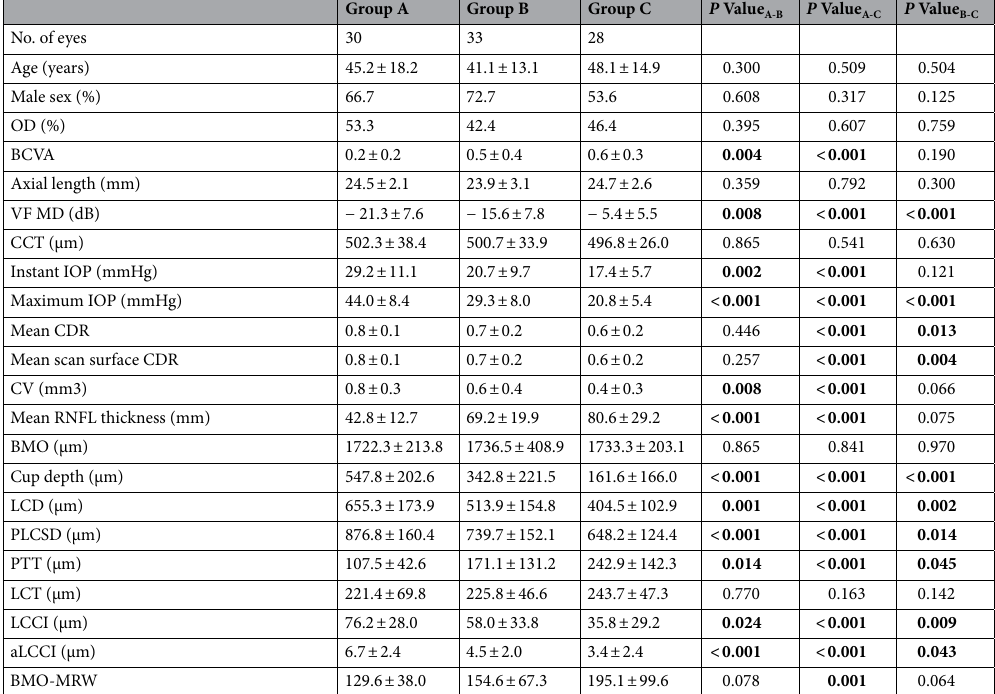
Table 2. Comparison of baseline parameters of study participants with IOP ≥ 30 mmHg (Group A), 21 mmHg ≤ IOP < 30 mmHg (Group B), and normal IOP (Group C). aLCCI = adjusted lamina cribrosa curvature index; BCVA = best-corrected visual acuity; BMO = Bruch’s membrane opening; BMO- MRW = Bruch’s membrane opening minimum rim width; CCT = central corneal thickness; CDR = cup-disk ratio; CV = cup volume; IOP = intraocular pressure; LCCI = lamina cribrosa curvature index; LCD = lamina cribrosa depth; LCT = lamina cribrosa thickness; MD = mean deviation; PLCSD = posterior lamina cribrosa surface depth; PTT = prelaminar tissue thickness; RNFL = retinal nerve fiber layer; VF = visual field. All values < 0.05 at t-test are presented in